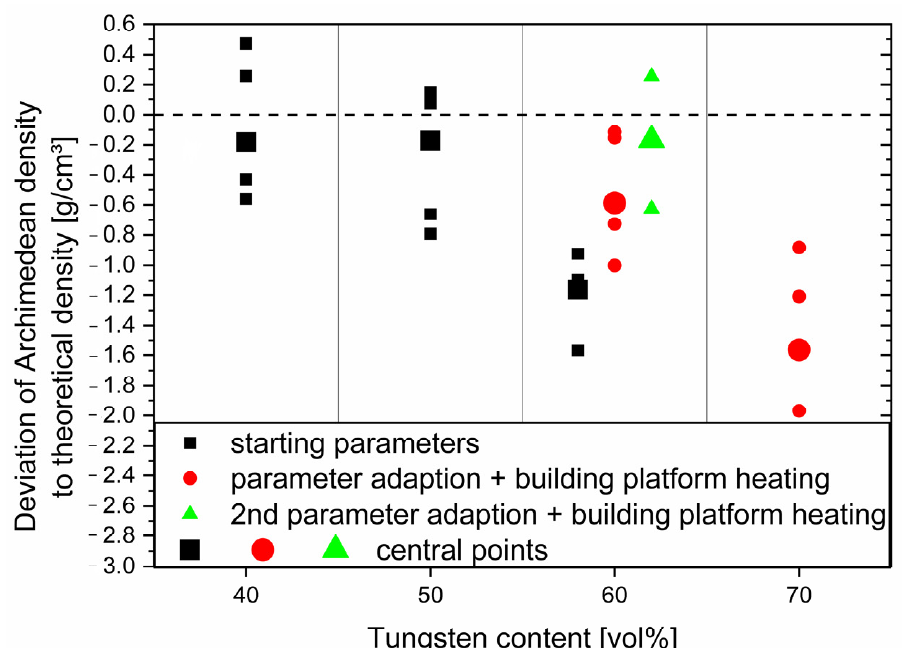
Figure 1. Archimedean density in comparison to the theoretical density for a variation of tungsten volume content and manufacturing parameters. The large markings present the mean of the central points.